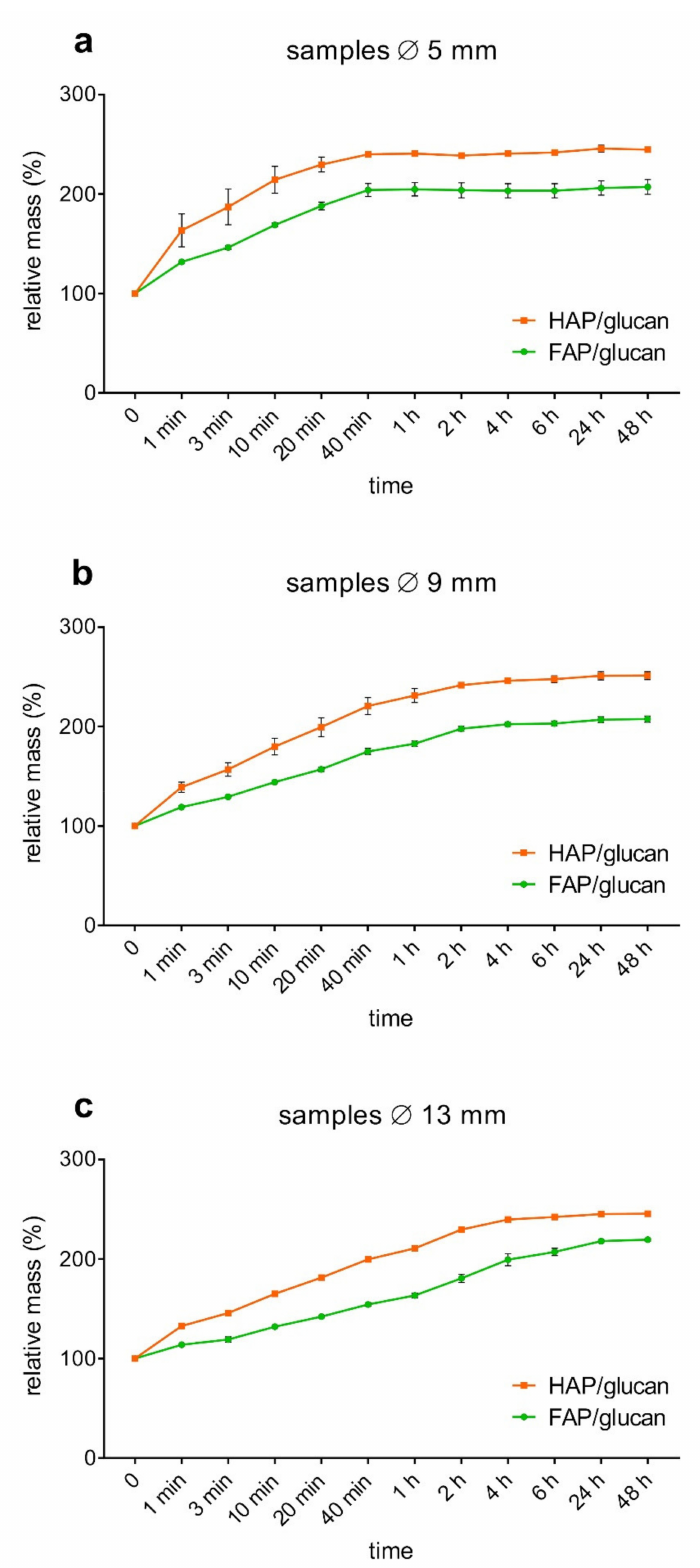
Figure 5. Relative weight change of composites samples soaked in Ringer solution.Panels: ( a ) samples Ø 5 mm, length 9 mm; ( b ) samples Ø 9 mm length 12 mm; ( c ) samples Ø 13 mm length 15